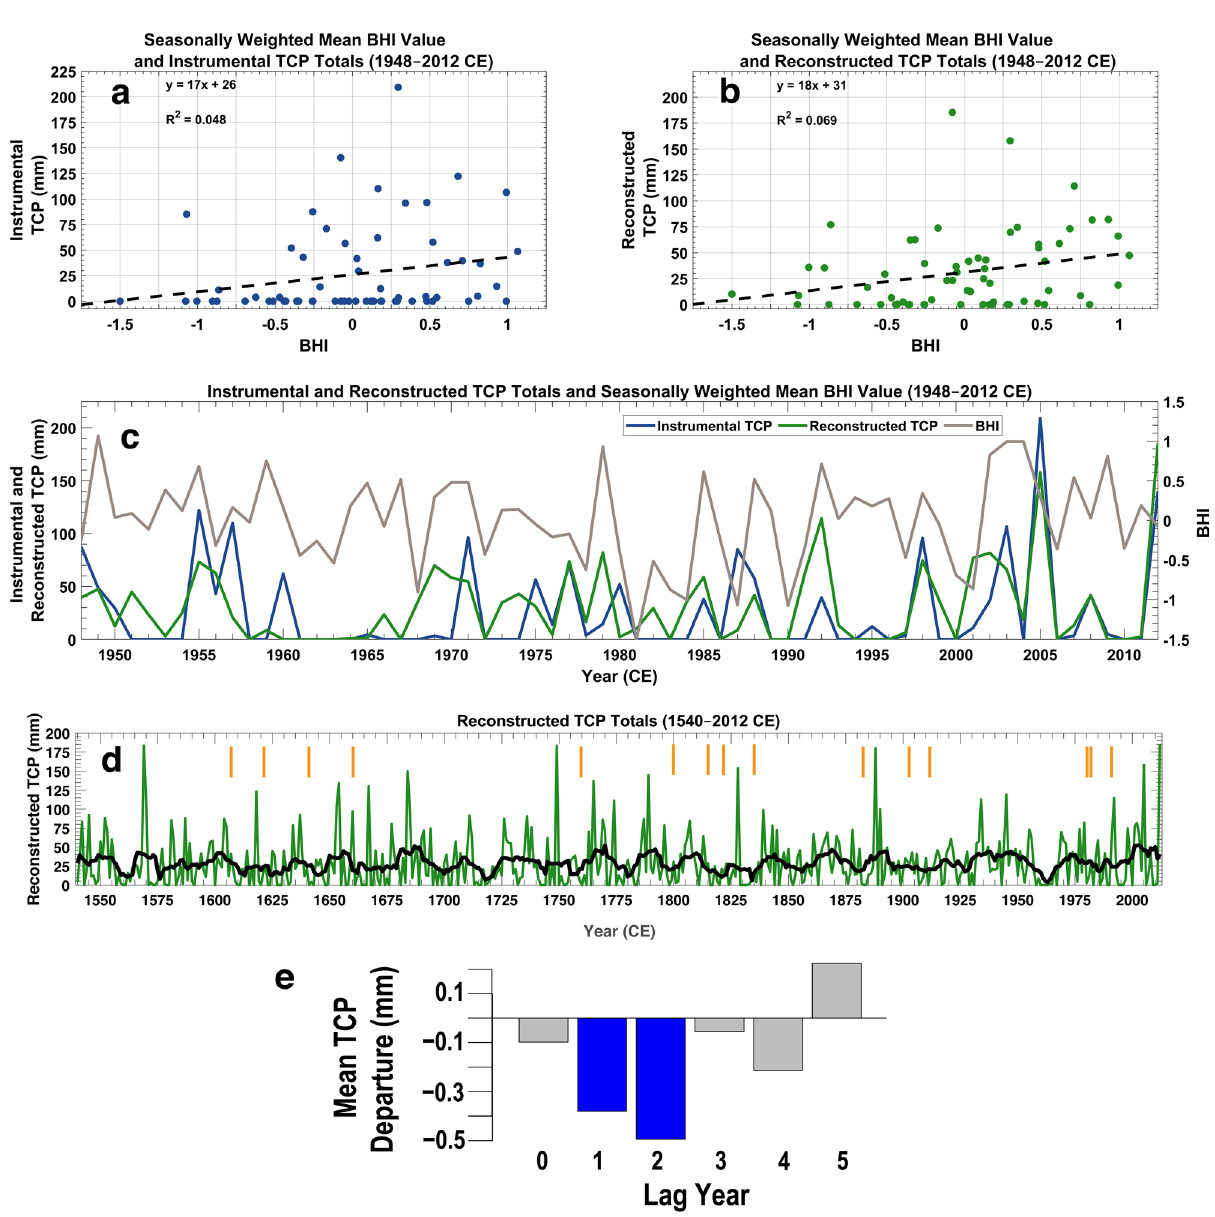
Fig. 3 Interannual climate controls of TCP. a Scatterplot between seasonally weighted mean BHI values and seasonal (July – September) instrumental TCP totals (mm) during the calibration period (1948 – 2012 CE). Monthly BHI was calculated following Katz et al. (ref. 38 ), and the seasonal mean BHI was weighted by the average number of tropical cyclone landfalls per month. Black dashed line is the linear regression model line. b Same as in a but using the reconstructed seasonal TCP totals instead. c Time series of mean BHI (light brown line), instrumental TCP totals (dark blue line), and reconstructed TCP totals (green line) during the calibration period. d Annually resolved reconstruction of seasonal TCP totals (green line), a 10-year running average (black line), and volcanic eruptions (orange markers; Supplementary Table 3) for the study period (1540 – 2012 CE). e Superposed epoch analysis between TCP and volcanic eruptions, which were selected following the methods described in Altman et al. (ref. 43 ). Analysis extended to 5 years following an eruption, with columns indicating the departure from the mean during lag years 0 – 5. Blue shading on bars indicates signi fi cance ( p <